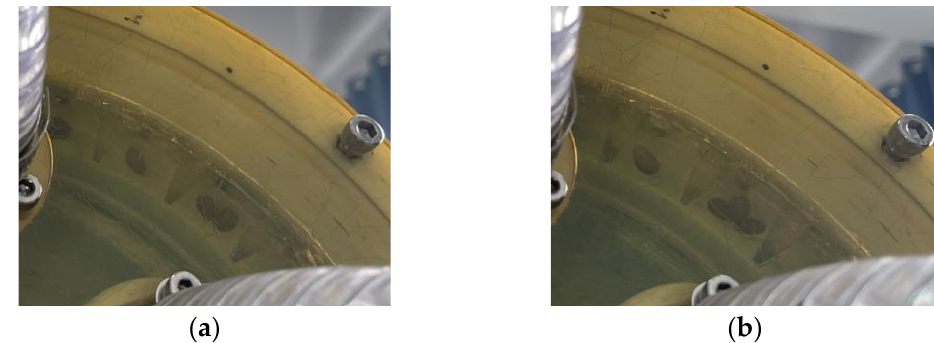
Figure 4. Adsorption of multiple cotton seeds after the separate action of the seed-cleaning scraper: ( a ) two cotton seeds and ( b ) three cotton seeds.